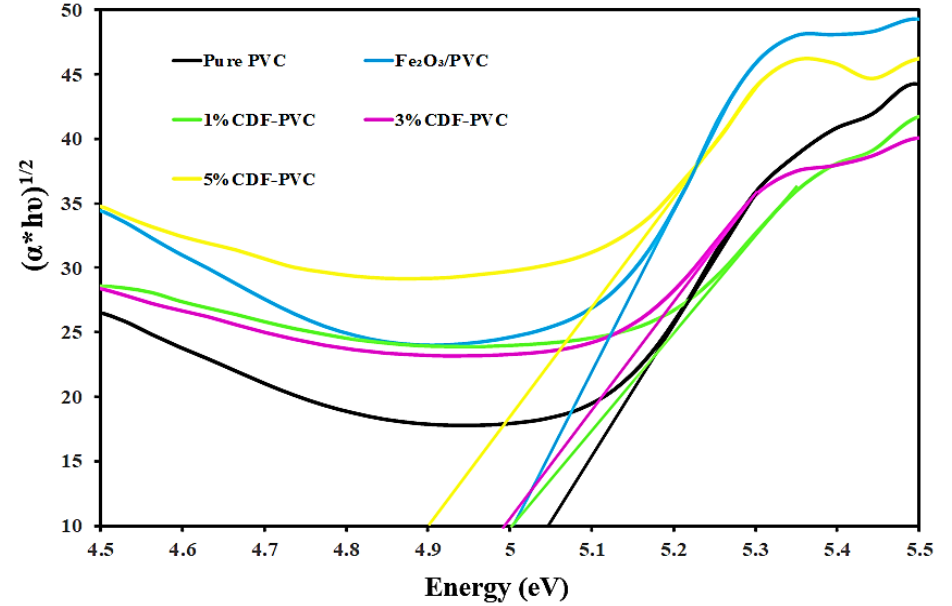
Figure 7. A comparison of the indirect bandgap of PVC films and their composites.